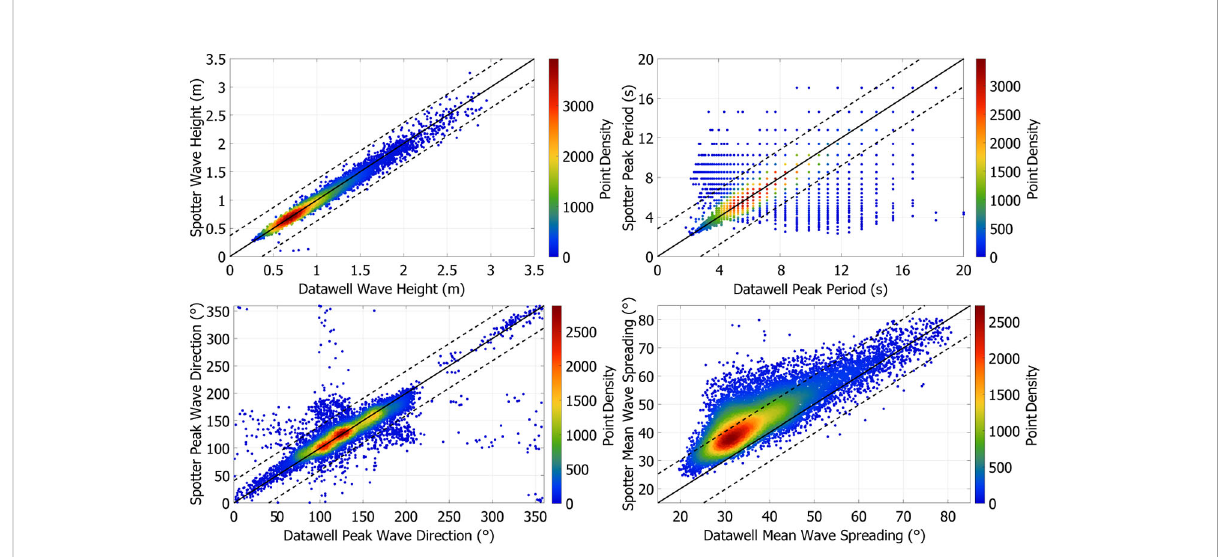
FIGURE 4 Density scatter plots of signi fi cant wave heights (top left), peak periods (top right), peak wave directions (bottom left), and mean wave spreading (bottom right) values reported by the Datawell and Spotter wave buoys. The solid black line through the origins shows a 1:1 relationship between the two buoys; the dashed black lines show one standard deviation for the Datawell from the 1:1 line.